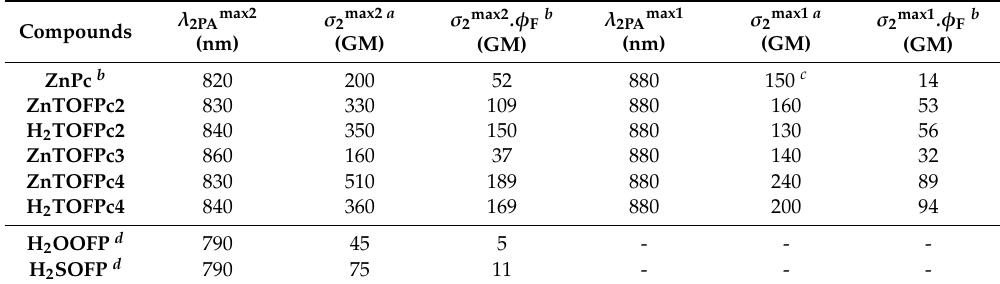
Table 2. Two-photon absorption of new phthalocyanines in THF at 20 ◦